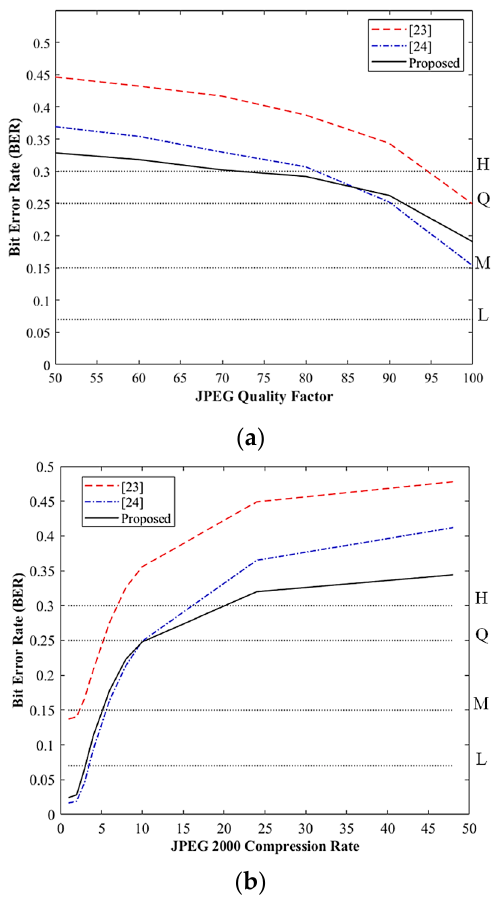
Figure 11. Performance comparison in terms of compression. ( a ) BER vs. JPEG, ( b ) BER vs. JPEG2000.